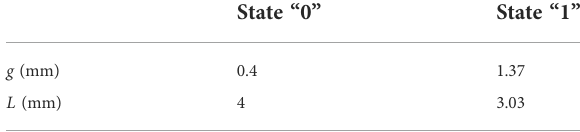
TABLE 1 Structure parameters of states “ 0 ” and “ 1 ”